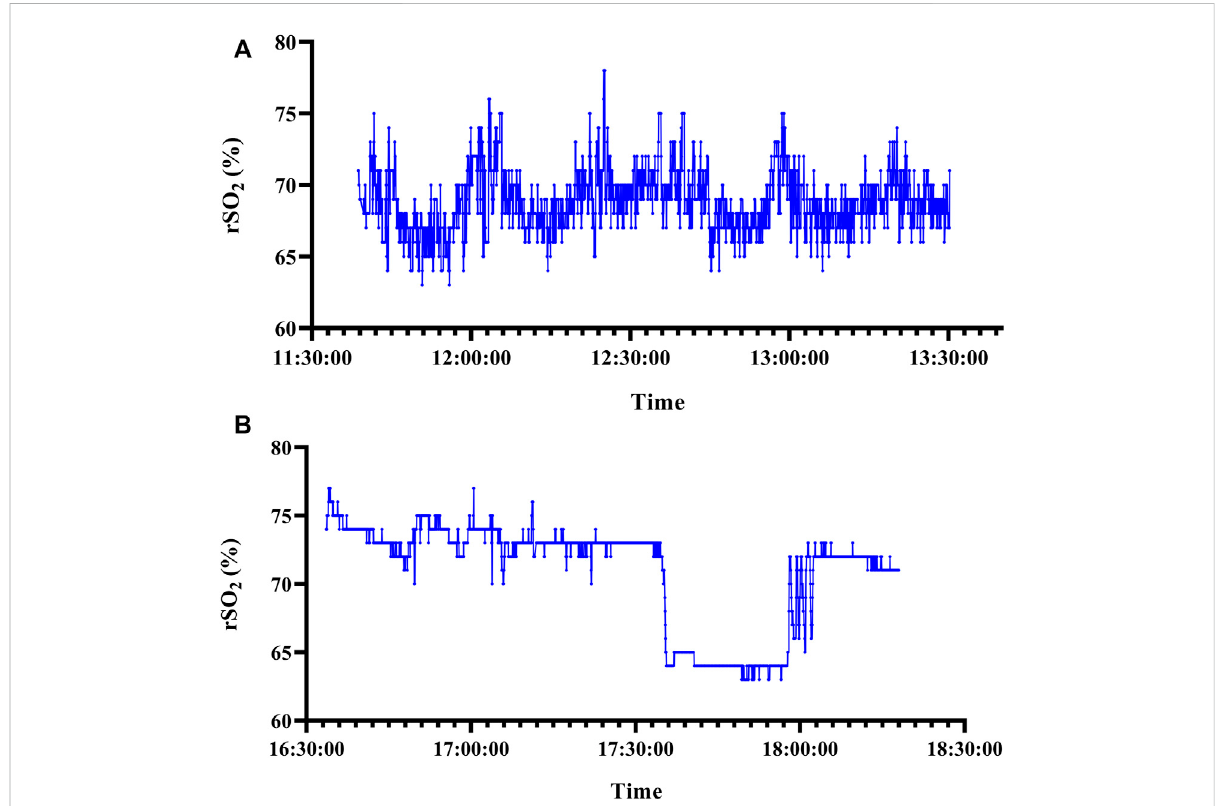
FIGURE 1 Typical tracings of rSO 2 measured by NIRS in the POCI group. Sample entropy was 0.800. rSO 2 , regional cerebral oxygen saturation; NIRS, Near-infrared spectroscopy; POCI, postoperative cognitive improvement. Typical tracings of rSO 2 measured by NIRS in the non-POCI group. Sample entropy was 0.123, respectively. rSO 2 , regional cerebral oxygen saturation; NIRS, Near-infrared spectroscopy; POCI, postoperative cognitive improvement.